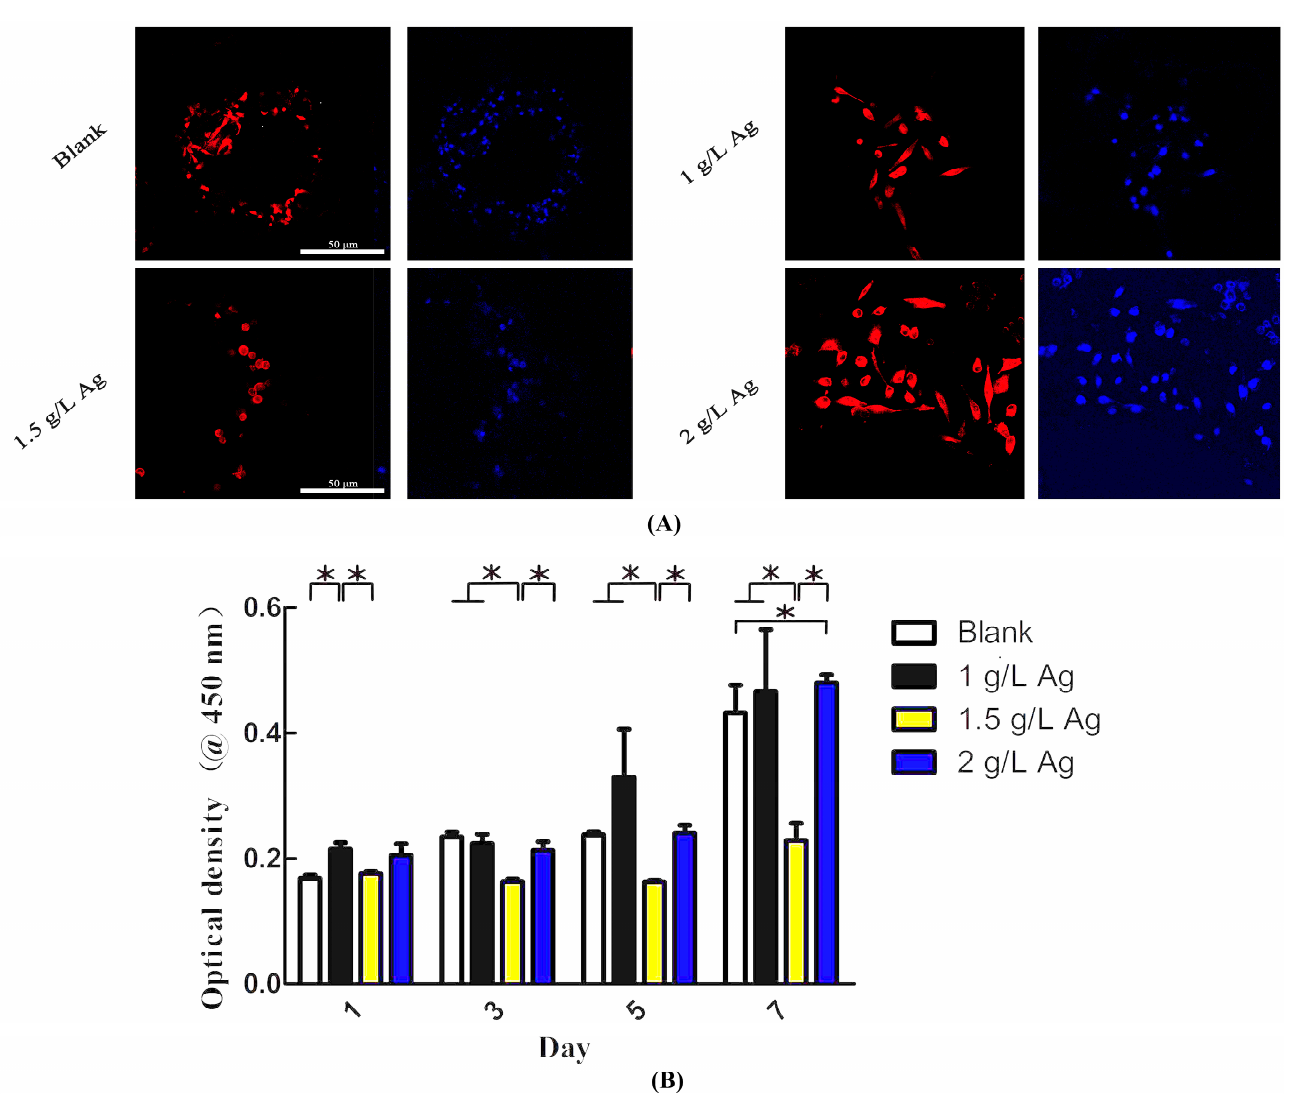
Figure 5. ( A ) Fluorescence images (stained with phalloidin and DAPI) of cells attached after 24 h of incubation; ( B ) CCK-8 assay showing the metabolic activity of MG-63 cells after 1, 3, 5, and 7 days of incubation (* p < 0.05; # p < 0.01) (the red color represents the cytoskeleton, and the blue color represents the nucleus).